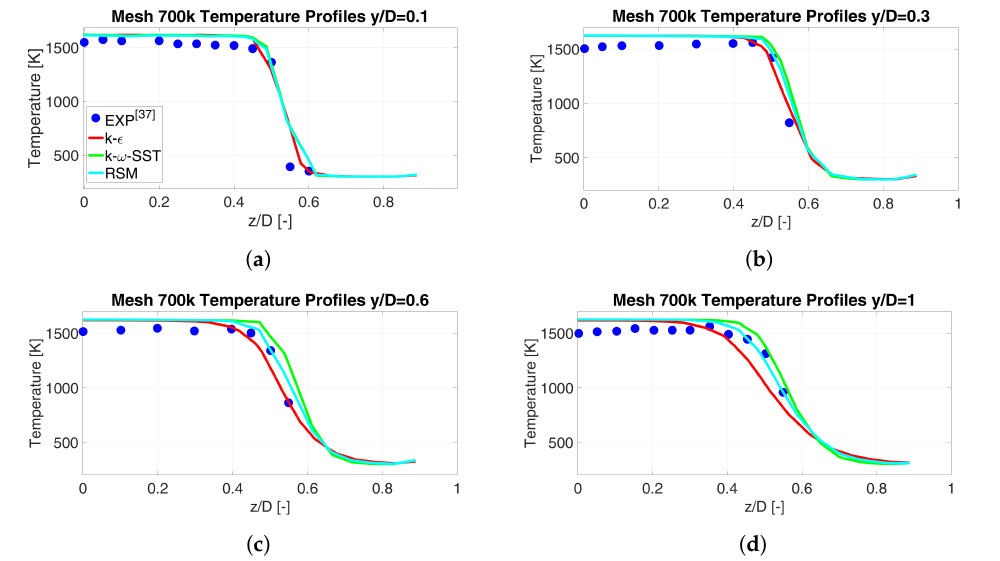
Figure 7. Study on turbulent closure: comparison between the experimental and numerical results in terms of the temperature profiles for the different turbulence models ( k - ε , k - ω SST, RSM) at different axial positions (( a ) y / D = 0.1, ( b ) y / D = 0.3, ( c ) y / D = 0.6, ( d ) y / D = 1) − reacting